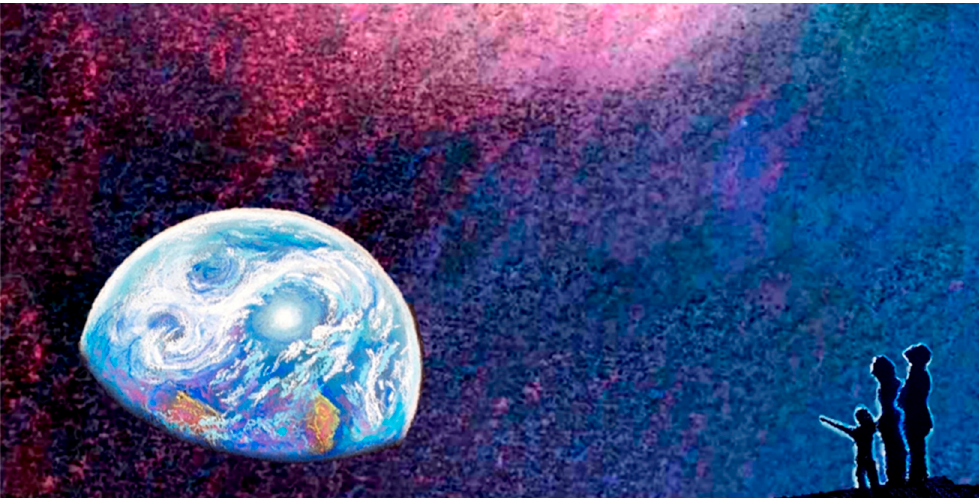
Figure 2. Striving for global high-level wellness requires restoration and preservation of the vitality and sustainability of the Earth’s natural systems—a universal philosophy of living, as advocated by Halbert Dunn [8]. [image by author, S.L.P.].